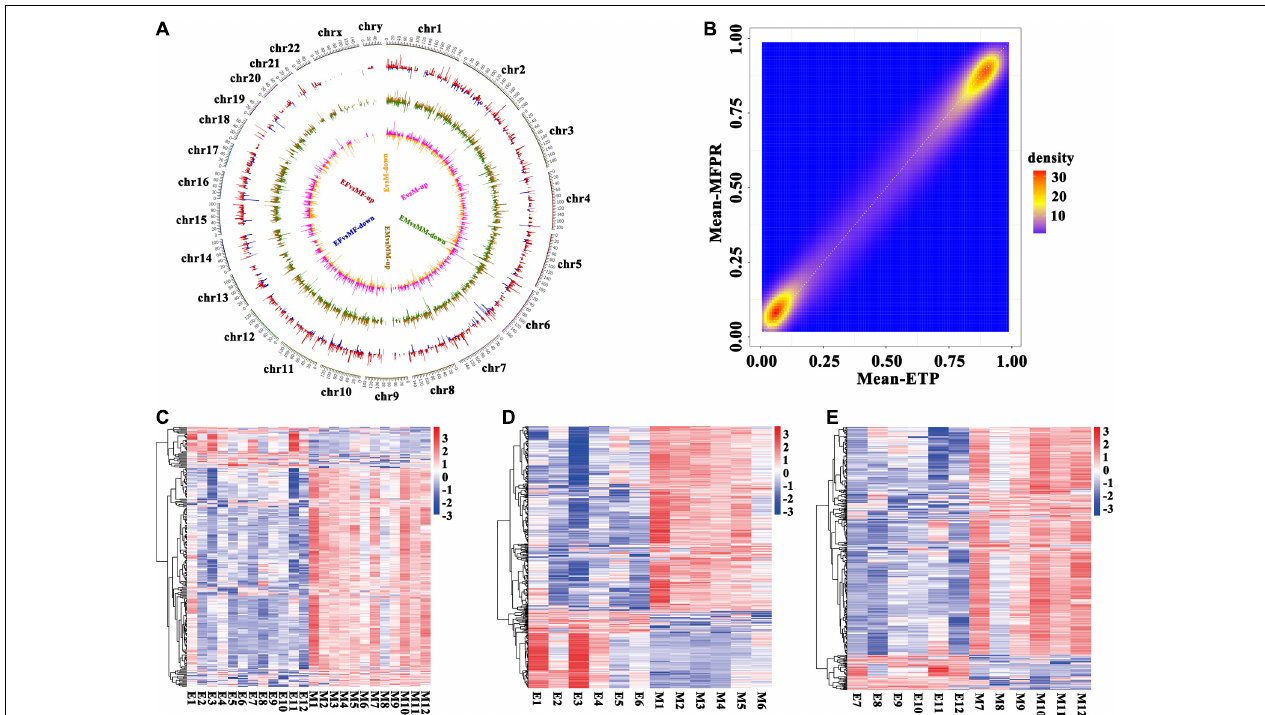
FIGURE 2 | Identification of differentially methylated regions (DMRs). (A) Circos plots of the distribution of the whole-genome DMRs within the 23 chromosomes. From outside to inside, the first circle shows chromosome distribution with numbers representing the parts each chromosome is divided equally, the second shows the DMRs in the ETP female vs. MFPR female groups (EF vs. MF), the third shows the DMRs in the ETP male vs. MFPR male groups (EM vs. MM) and the fourth shows the DMRs in the ETP vs. MFPR groups (E vs. M). Red color indicates higher levels and blue indicates lower levels of methylation in DMRs in the MFPR group than in the ETP female group. Brown color indicates higher levels and green indicates lower levels of methylation in DMRs in the MFPR group than in the ETP male group. Pink color indicates higher levels and yellow indicates lower levels of methylation in DMRs in the MFPR group than in the ETP group. Lines represent the difference in methylation levels between the two groups, and increasing length denotes difference in methylation level. (B) Density plots of genome-wide paired values of fetal tissue DNA methylation. The color represents two-dimensional transformed density (blue = low density, orange = high density). (C–E) Heatmap cluster analysis of DMRs in the whole genome. Each row represents an individual DMR, and each column represents one group. The colors in each block from blue to white to red sequentially represent methylation ratios from –3 to 0 to 3, respectively. (C) Heatmap cluster analysis of DMRs in the whole genome between ETP controls and the MFPR group. (D) Heatmap cluster analysis of DMRs in the whole genome between ETP male controls and the MFPR group. (E) Heatmap cluster analysis of DMRs in the whole genome between AB female controls and the MFPR